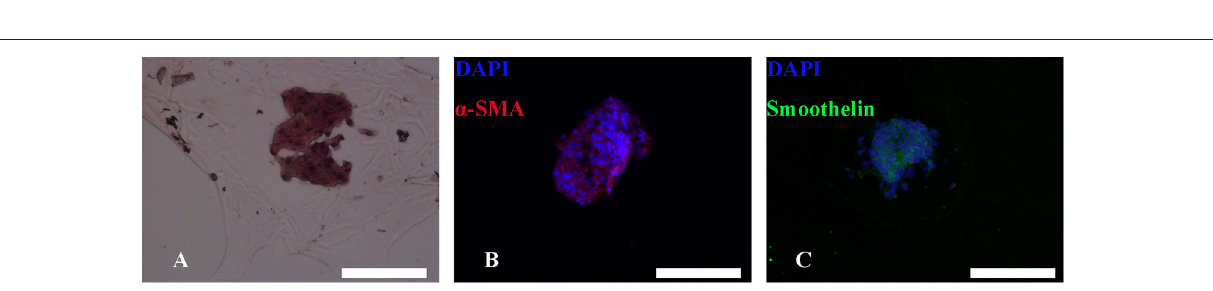
FIGURE 7 | HE and immunofluorescence of MTs in the bioprinted 3D structure. HE staining revealed that MTs could largely sustain their morphology after the bioprinting process (A) . Immunofluorescence confirmed induced MTs still had expression of α -SMA (B) and smoothelin (C) . Red, α -SMA; green, smoothelin; blue, DAPI; inset bar = 200 µ m.